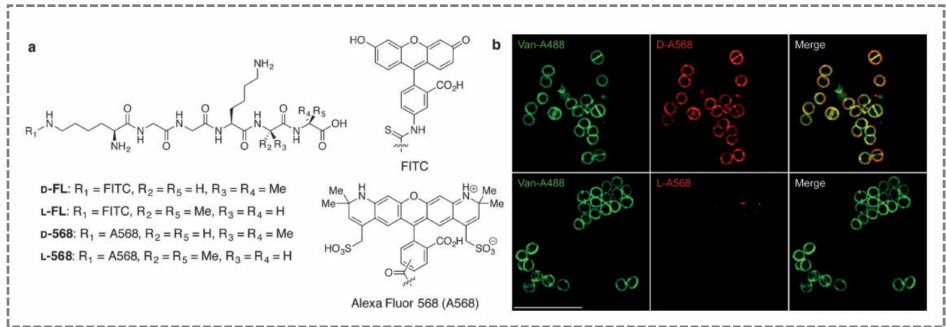
Figure 4. Labelled cell wall of S. aureus with stereoselective fluorescent stem peptide mimics: ( a ) chemical structures of probes D-FL and L-FL; D-A568 and L-A568; ( b ) representative images of structured illumination microscopy of S. aureus Newman labelled for 1 h with D-A568 (top panels) or L-A568 (bottom panels). Both samples were treated with Van-A488, which stains the entire cell wall of S. aureus (left panels). Scale bar: 5 µ m (reproduced with permission from Gautam et al. (2015) [66], Copyright 2015,